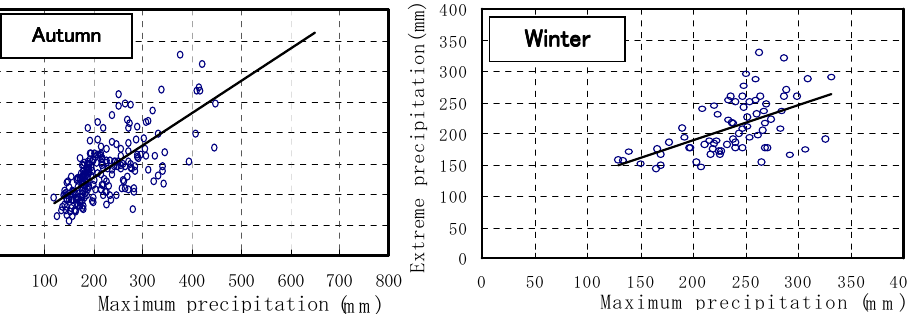
Fig. 3. Relationships between maximum monthly rainfall and the extreme precipitation for 30 years return period in each season. Figure 3. Relationships between maximum monthly rainfall and the extreme carried out for areas having their maximum rainfall in au- precipitation for 30 years return period. tumn, winter, and spring + summer.